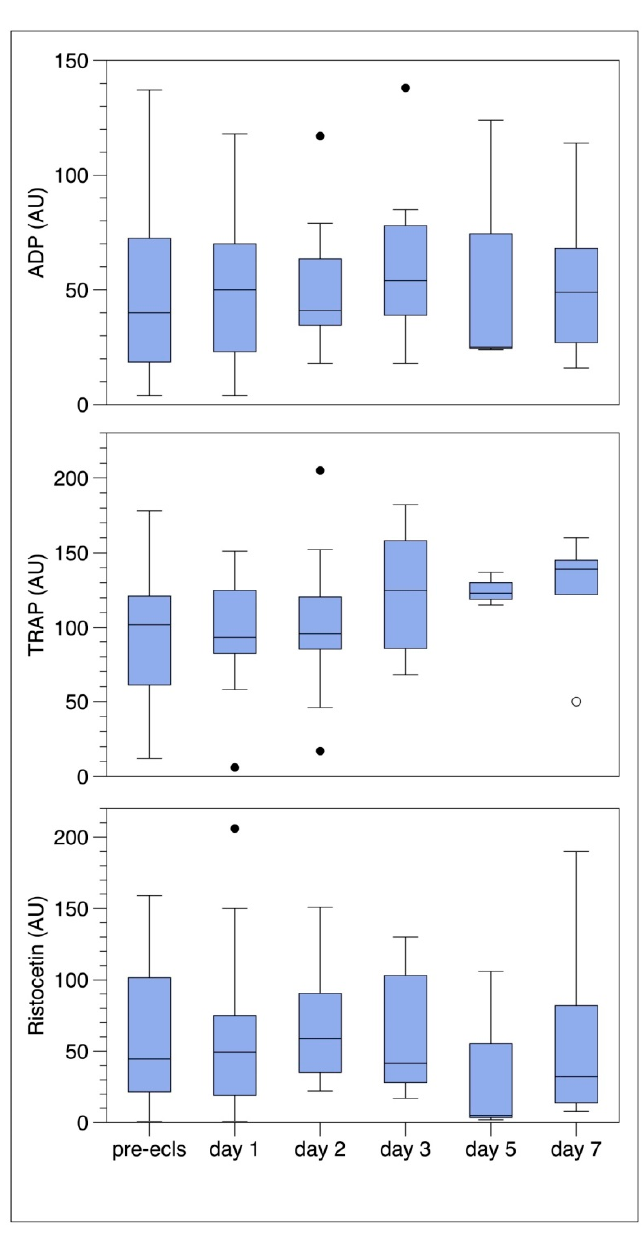
Figure 5. Platelet aggregation analysis with Multiplate after stimulation with ADP, TRAP and Ristocetin prior to start of ECMO and on days 1, 2, 3, 5, and 7. Boxes represent the interquartile range (25%–75%), dots represent the outliers. ECLS = extracorporeal life support.